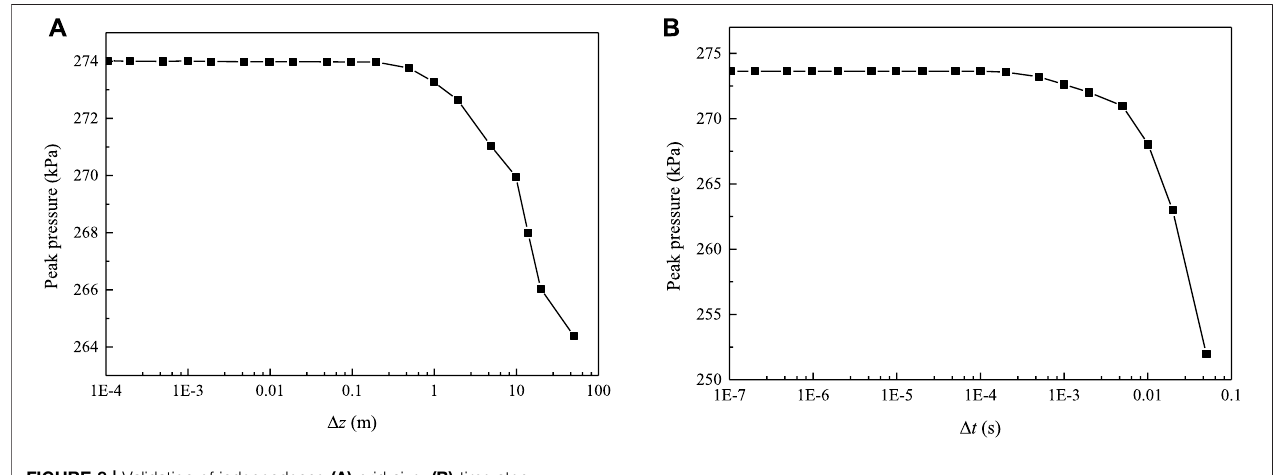
FIGURE 8 | Validation of independence (A) grid size. (B) time